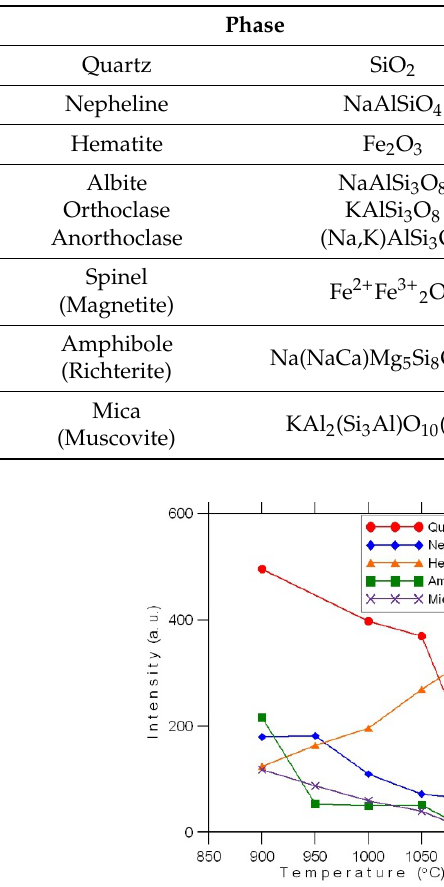
Table 2. Crystalline phase in the ceramic samples.